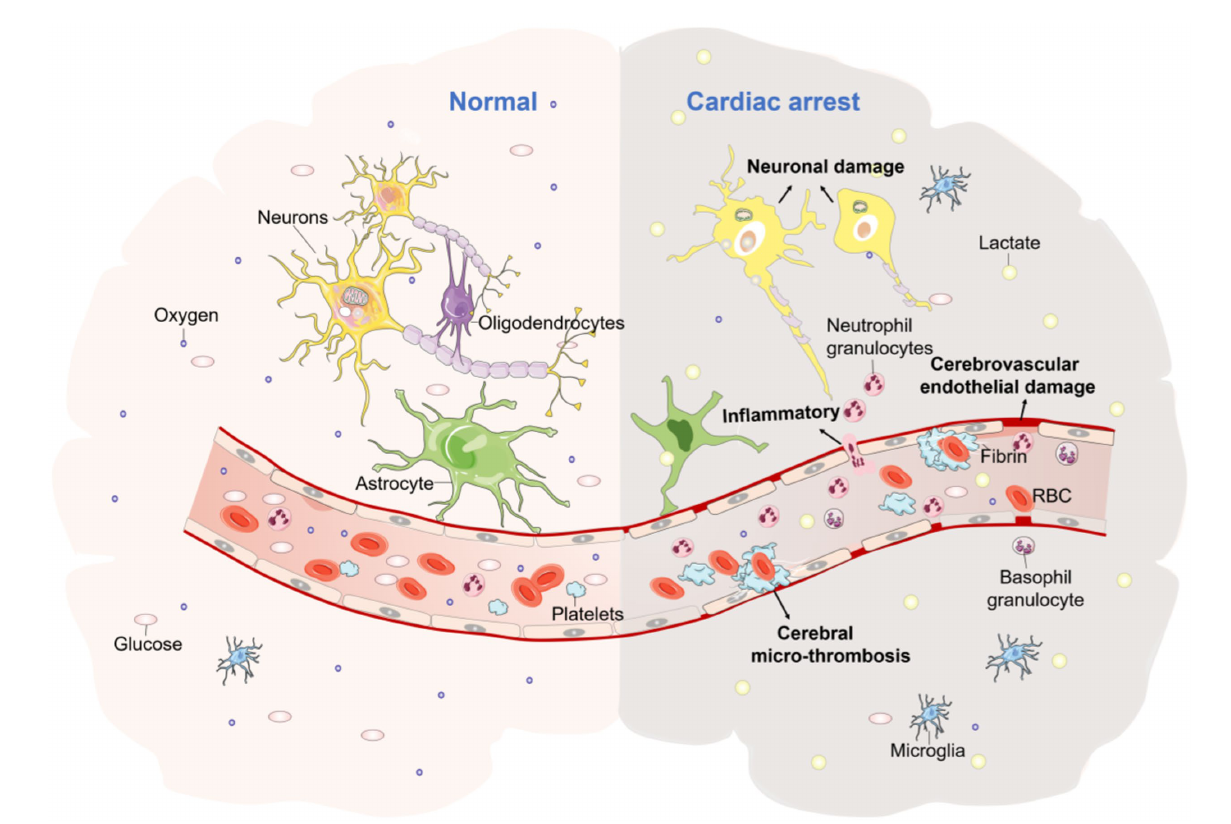
FIGURE 1 The pathophysiological mechanisms of CA brain injury. The picture represents the morphological changes in brain tissue due to ischaemia and hypoxia following CA, with increased lactic acid, cerebrovascular endothelial damage, increased inflammatory cells, cerebral micro-thrombosis, neuronal damage, dendritic morphological changes, and a range of other pathological processes